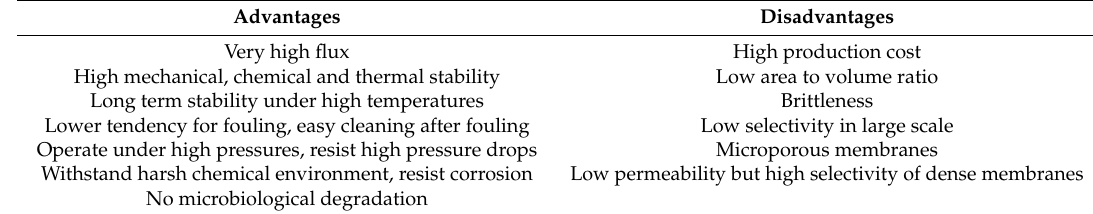
Table 4. Advantages and disadvantages of ceramic